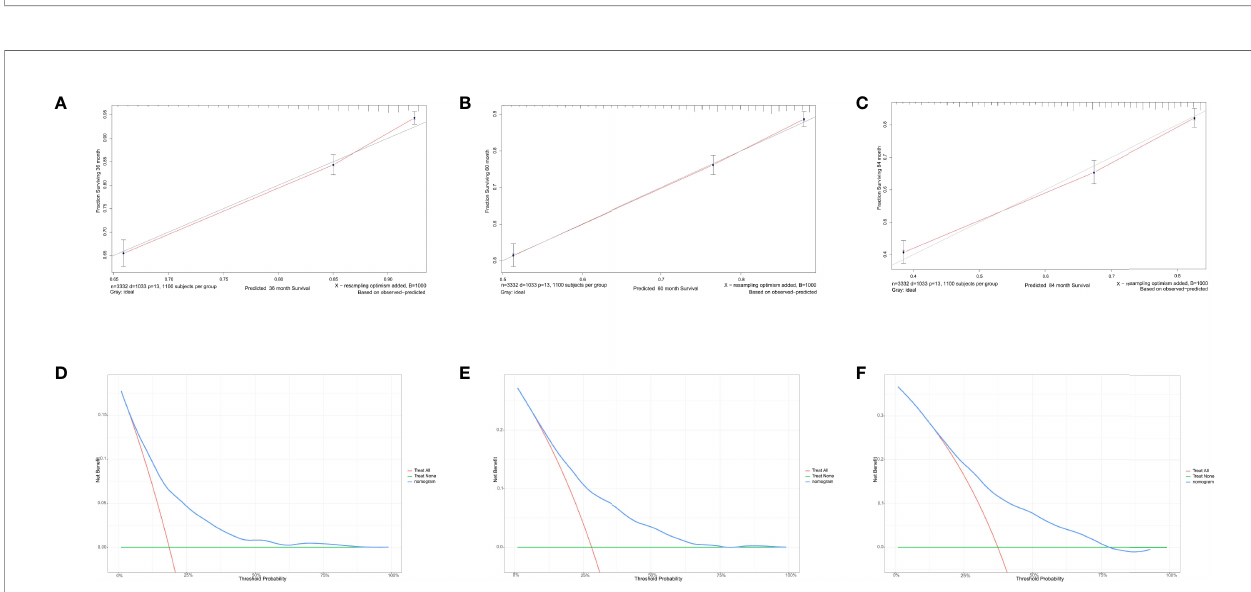
FIGURE 6 | The predictive model for predicting the long-term overall survival probability in women aged 70 years or older with primary operable, triple-negative breast cancer in the training cohort. (A) Nomogram for predicting the 3-, 5-, and 7- year OS for elderly primary operable TNBC patients. (B) The receiver operating characteristics (ROC) curve and area under the ROC curve (AUC) in the training cohort. (C) The receiver operating characteristics (ROC) curve and area under the ROC curve (AUC) validating